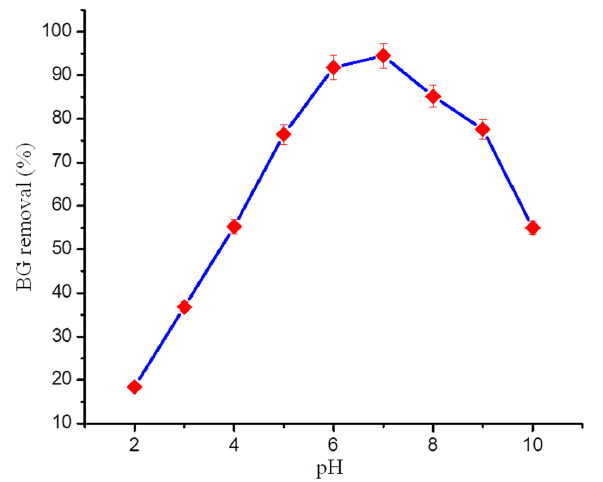
Figure 3. pH plot for BG adsorption on GO-PANI.